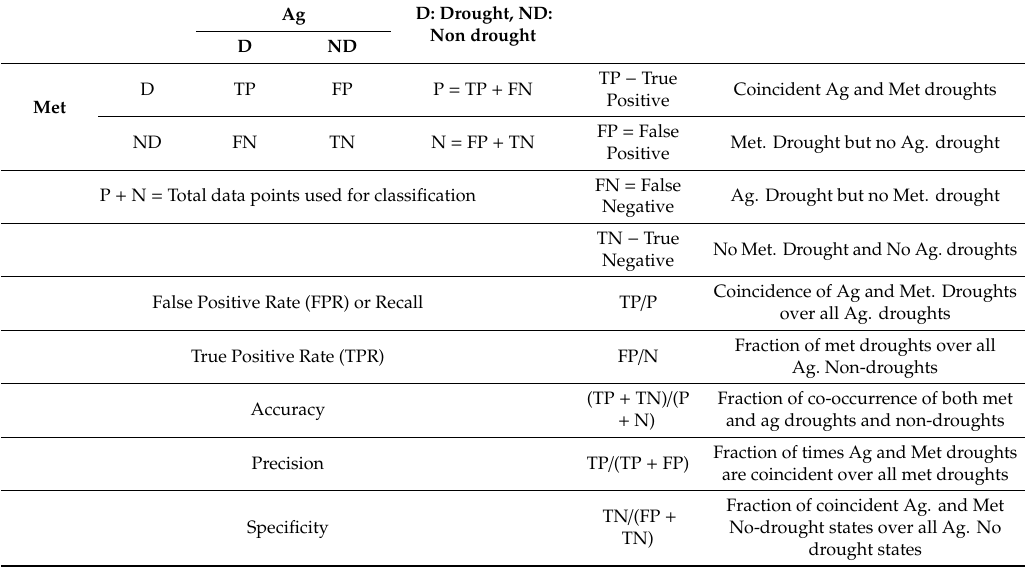
Table 1. Contingency Table and Receiver Operator Characteristics (ROC) as they pertain to Agricultural and Meteorological Drought